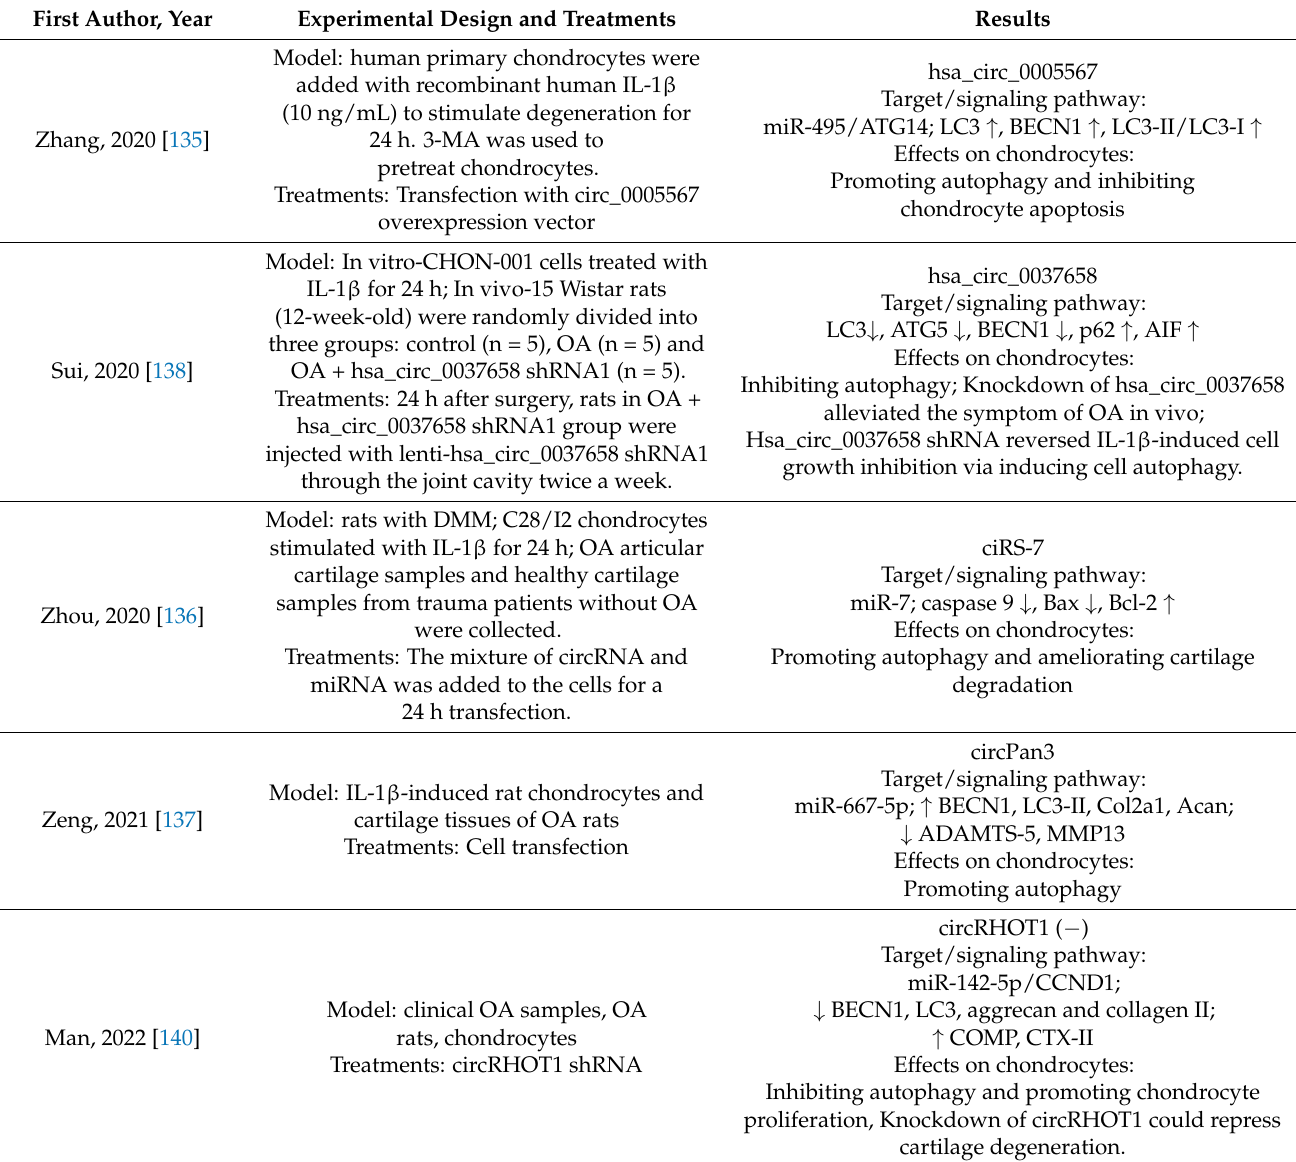
Table 2. CircRNA regulation of autophagy in